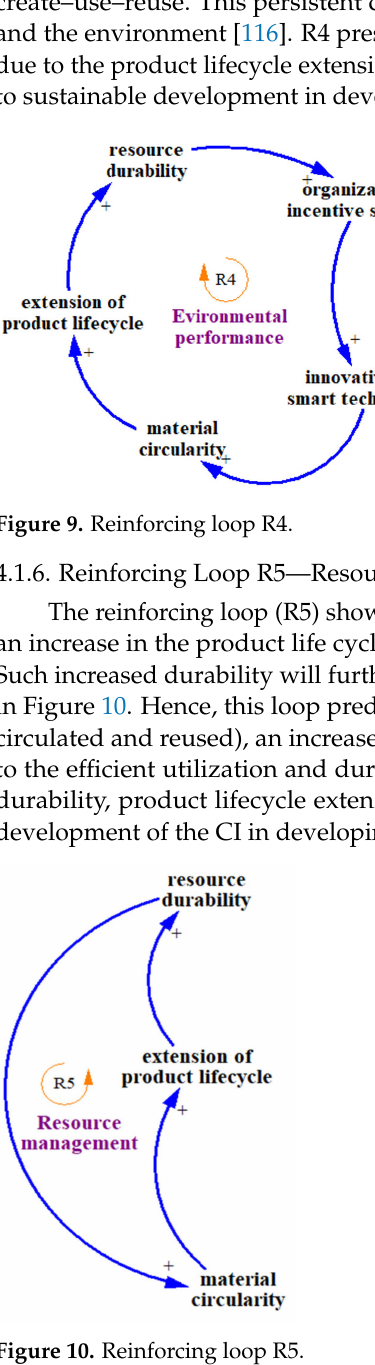
Figure 10. Reinforcing loop